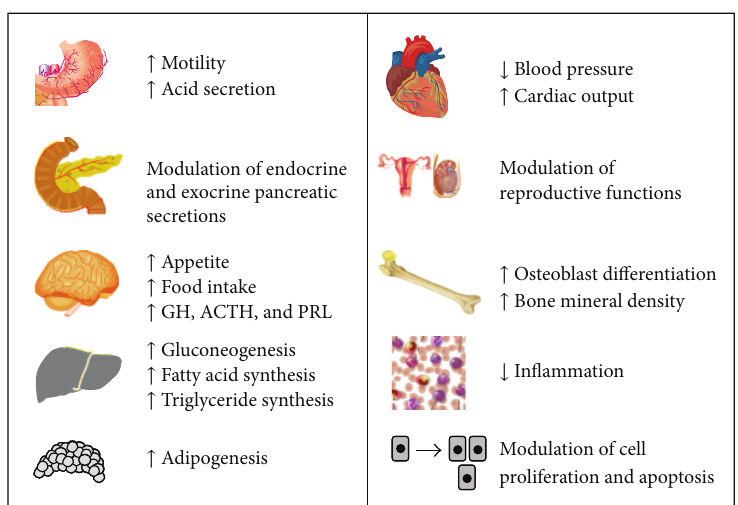
Figure 5: Main physiological functions of ghrelin.